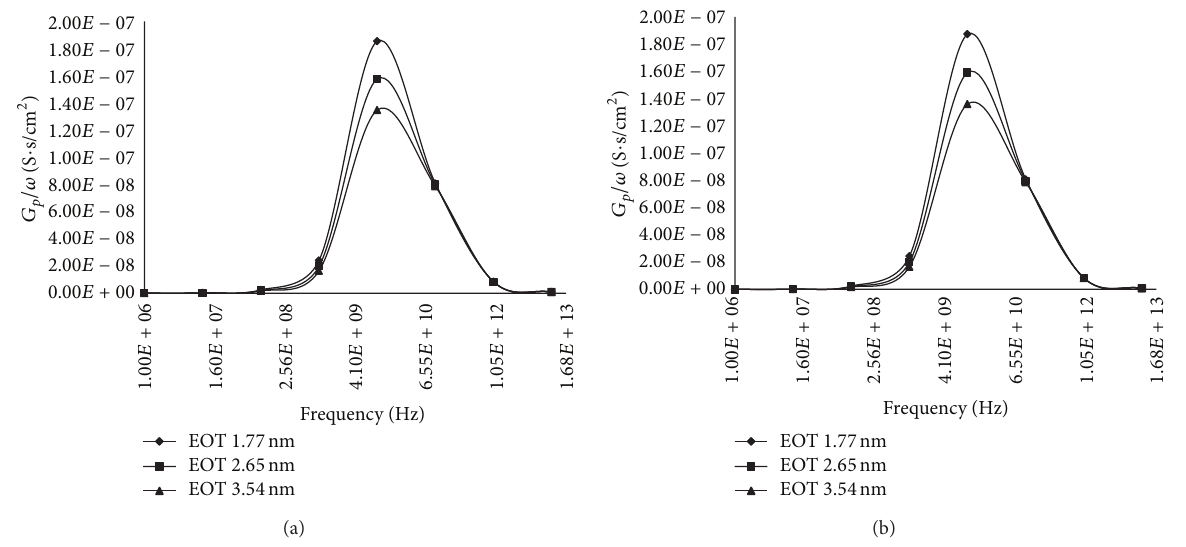
Figure 5: 𝐺 𝑝 /𝜔 and frequency for (a) ZrO 2 and (b) HfO 2 at different EOT.